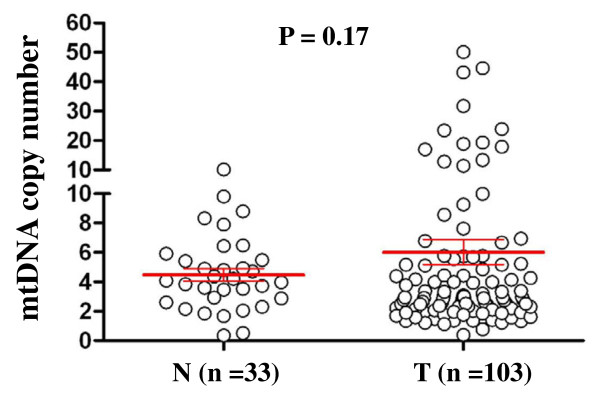
Copy number of mtDNA corresponding to each individual case of gastric cancers and normal gastric tissues (circle). Real-time quantitative PCR assay was performed to analyze mtDNA copy number in a cohort of gastric cancers and normal gastric tissues. Horizonal lines represent mean ± S.E. Details are as described in Methods. T, tumor tissues; N, normal gastric tissues.